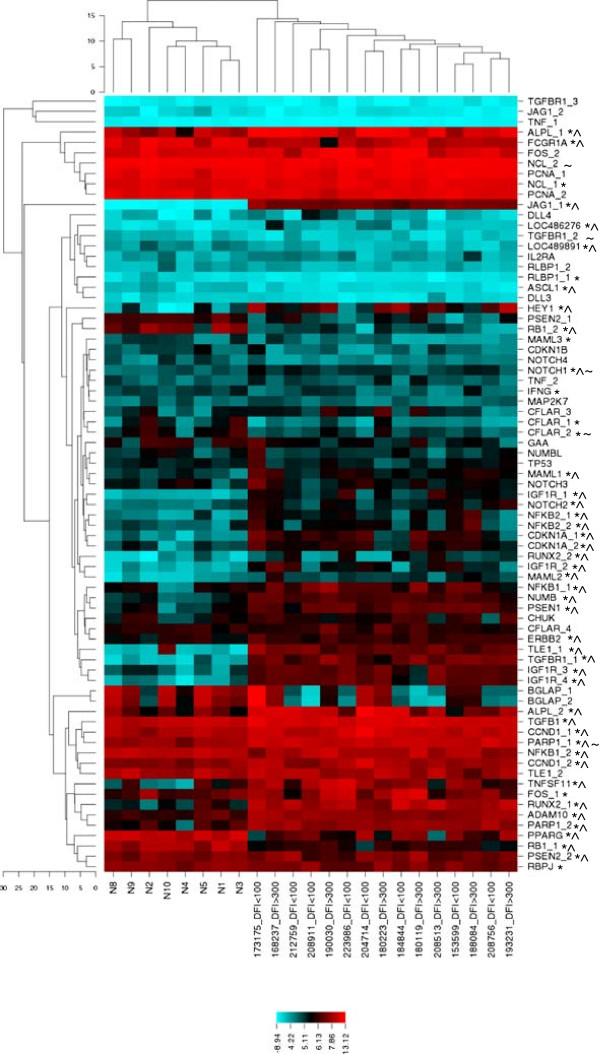
Differential expression of Notch/HES1-associated genes in canine osteosarcoma. Unbiased cluster analysis separates normal bone from tumors, but does not discriminate DFI < 100 day and DFI > 300 day primary tumors groups. An asterisk (*) and a caret (^) denote genes significantly different between tumor and normal bone (* p < 0.05, ^ q < 0.05). Genes different between DFI groups (p < 0.05) are denoted by (~). Multiple probesets are present for some genes. LOC486276 = Deltex 1 homolog (DTX1), LOC489891 = LFNG O-fucosylpeptide 3-beta-N-acetylglucosaminyltransferase/lunatic fringe (LFNG). Colored bar below indicates the intensity scale of log2 transformed expression values.